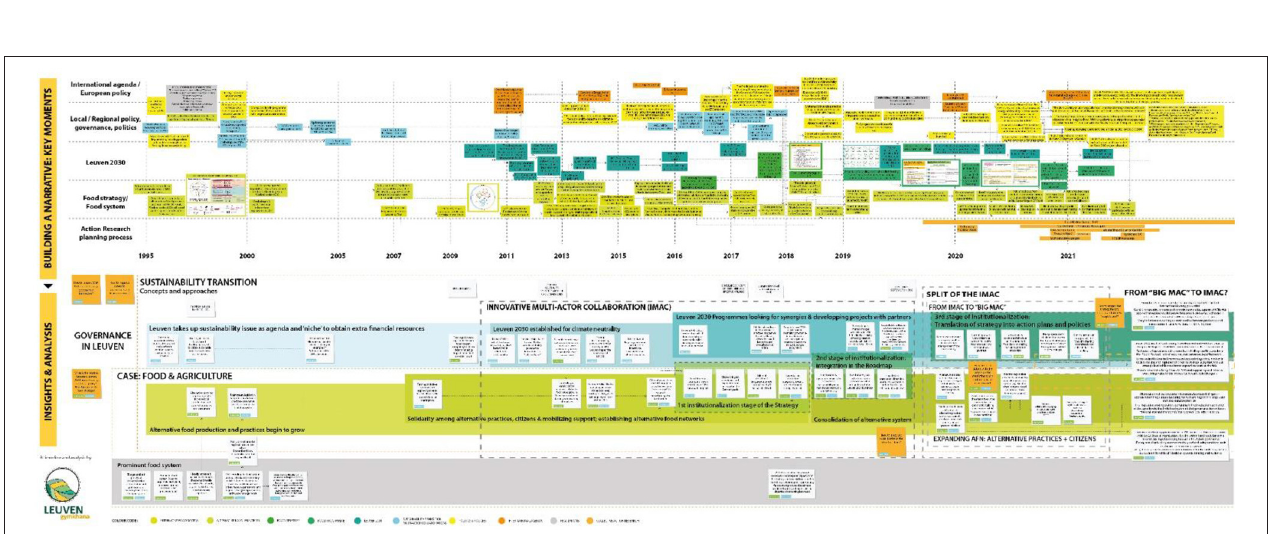
FIGURE 3 | Timeline of the results and insights gathered on governance innovation in the governance of Leuven’s food system. Attached as Supplementary Material in high resolution. (Source: authors’ elaboration).